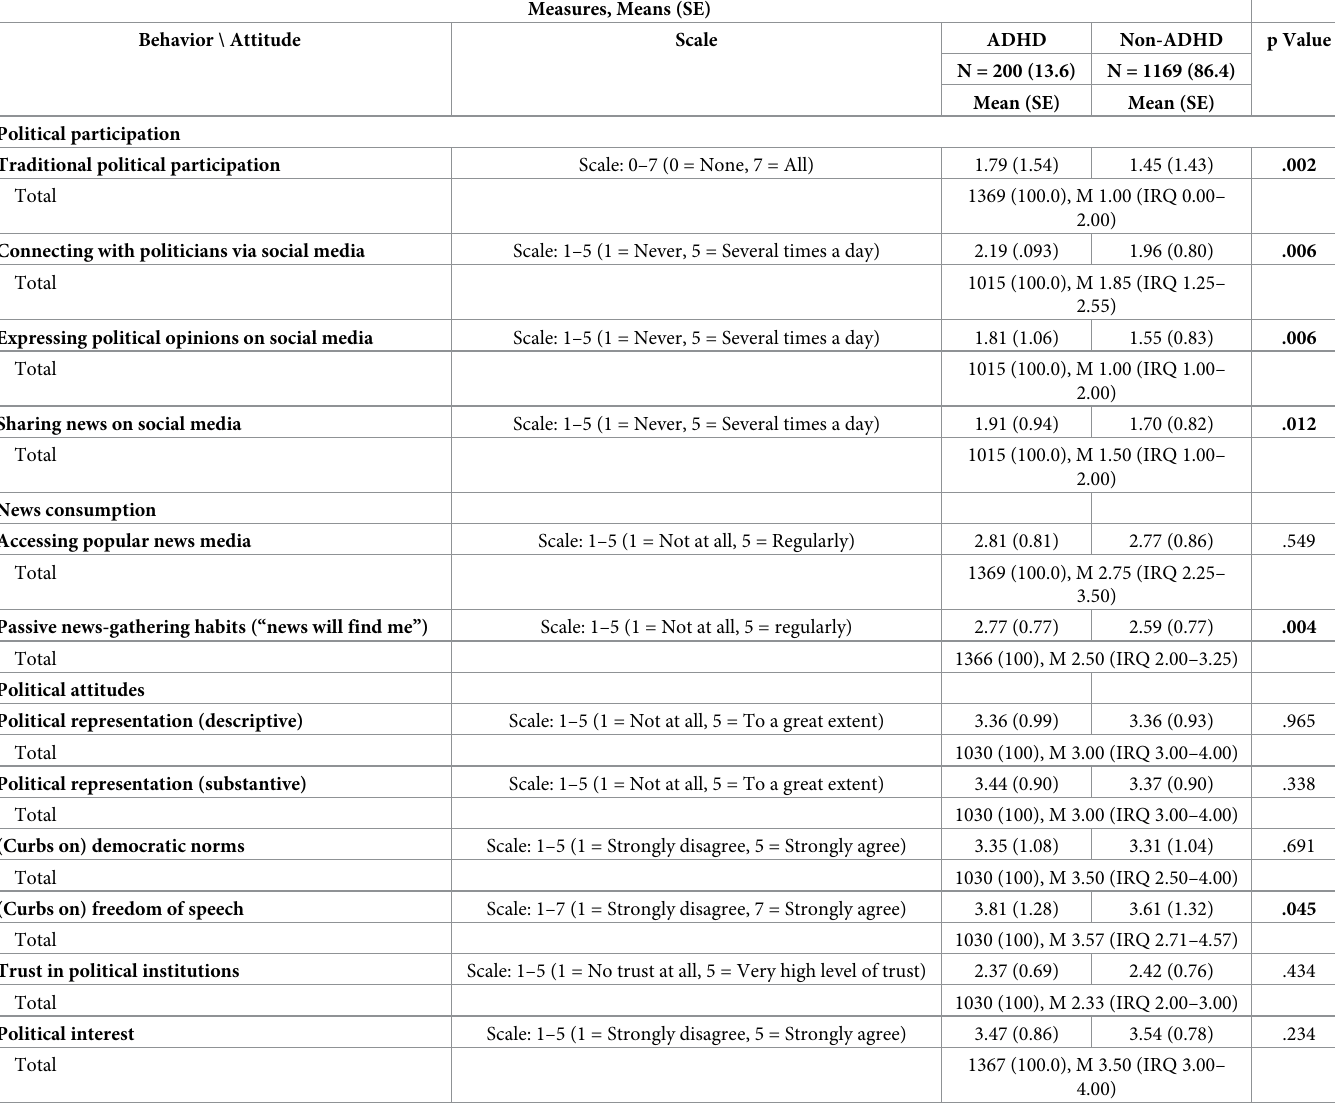
Table 2. Political attitudes and participation patterns of the study population—dichotomous analysis (ADHD vs.